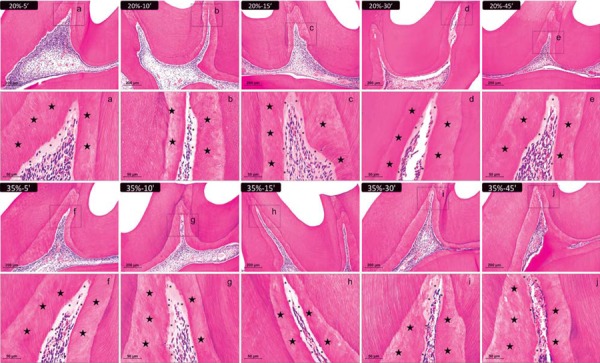
Representative images of H&E-stained sections showing the coronal pulp 30 days after bleaching. Panels a, b, c, d, and e represent the groups treated with 20% H2O2 gel and panels f, g, h, i, and j represent those treated with 35% H2O2 gel for 5, 10, 15, 30, and 45 min, respectively (×100 magnification). Panels a-j are magnified images (×400) of the insets in panels a-j, respectively. The stars indicate the reparative dentin layer; the asterisks show the predentin layer. The values of the area of the pulp chamber were obtained, as shown in Figure 1, to carry out the statistical analysis. H&E=hematoxylin & eosin